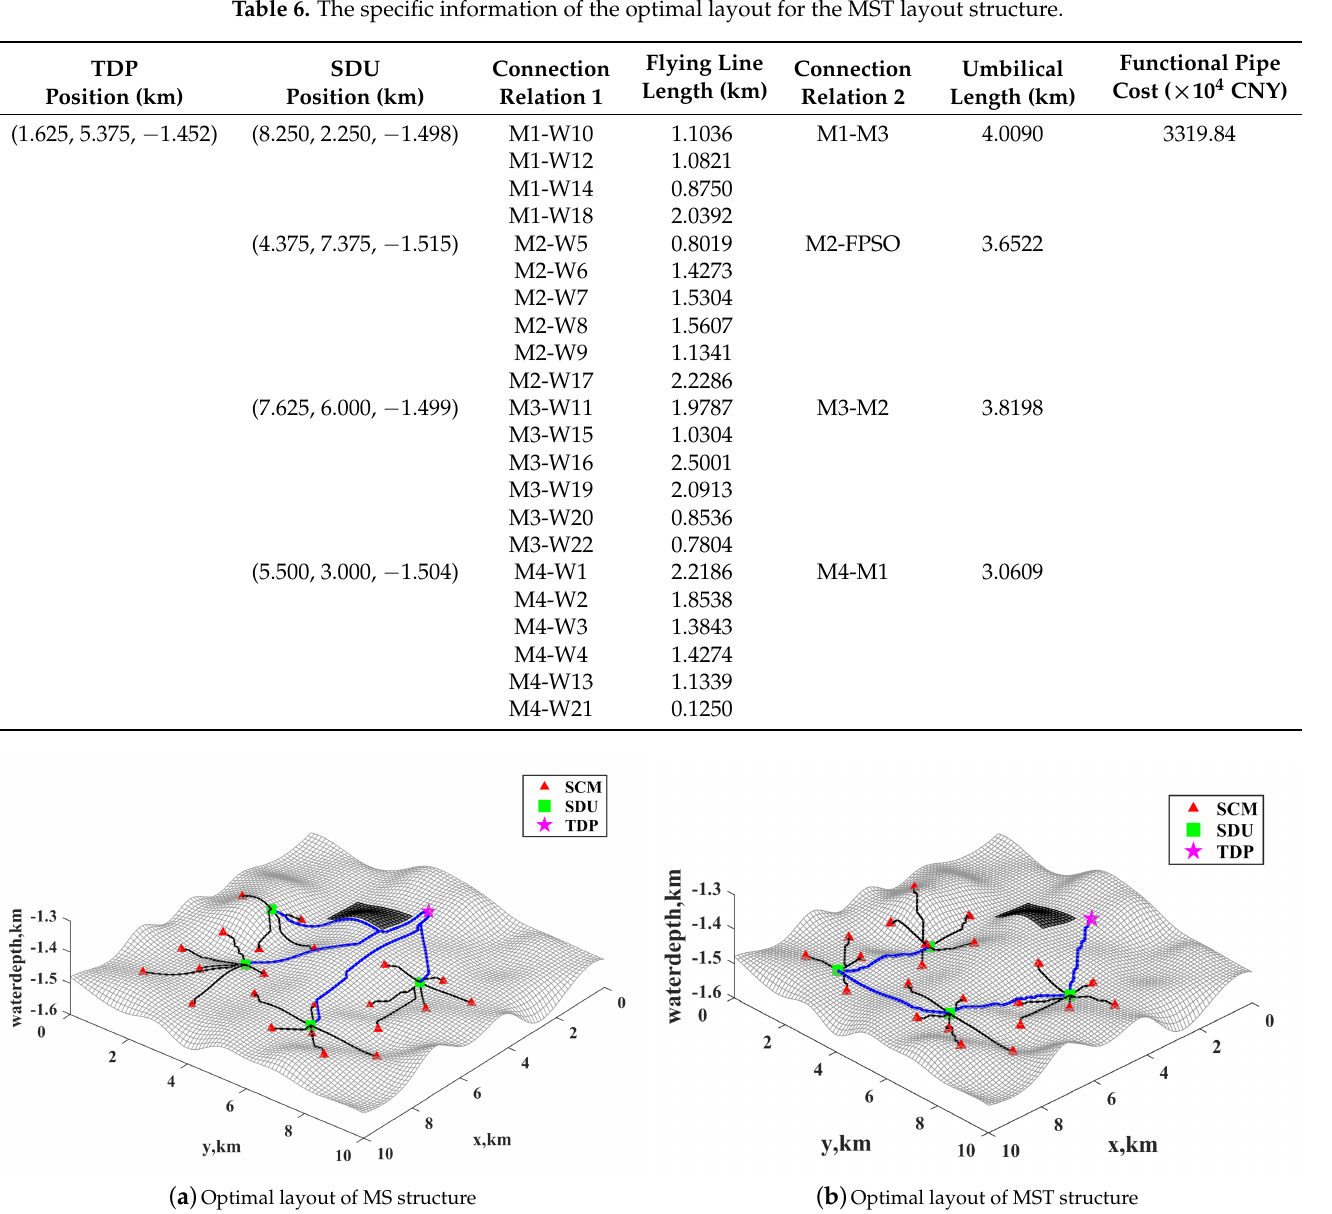
Figure 8. Optimal layout in three-dimensional space for the two layout